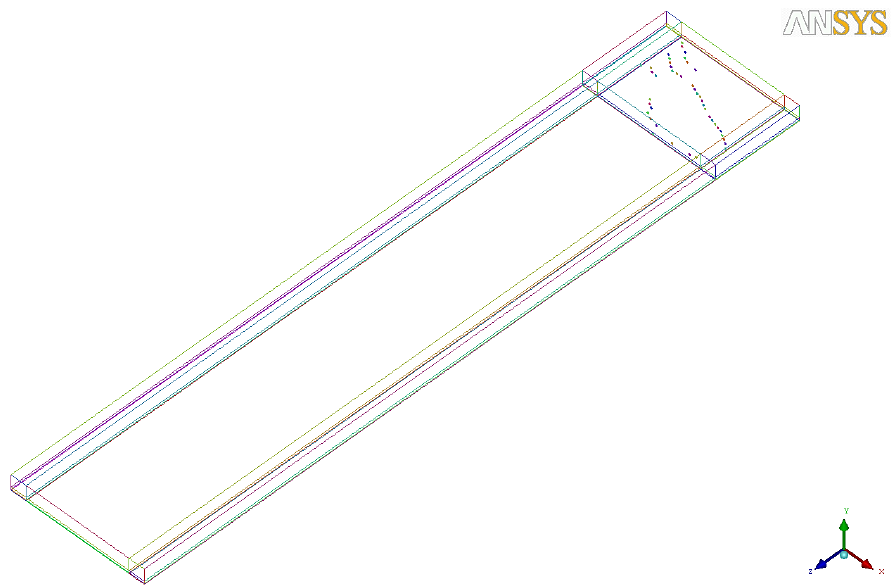
Figure 3. The multi-block computational domain with a total size of 7 km × 0.8 km × 34.4 km .